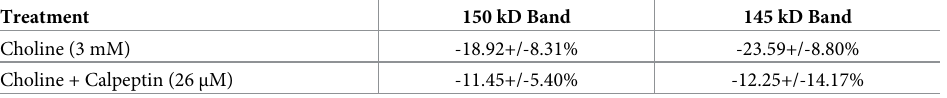
Table 2. Band density analysis of α IIspectrin breakdown in cells transfected with the α 7 345-8A subunit based on percent change from α 7 345-8A transfected